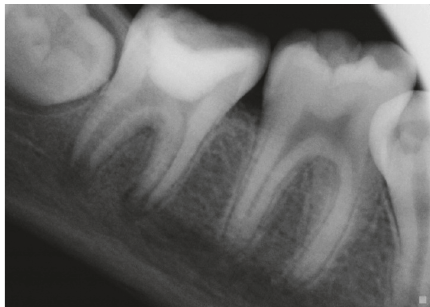
Figure 3: Control radiograph after capping with